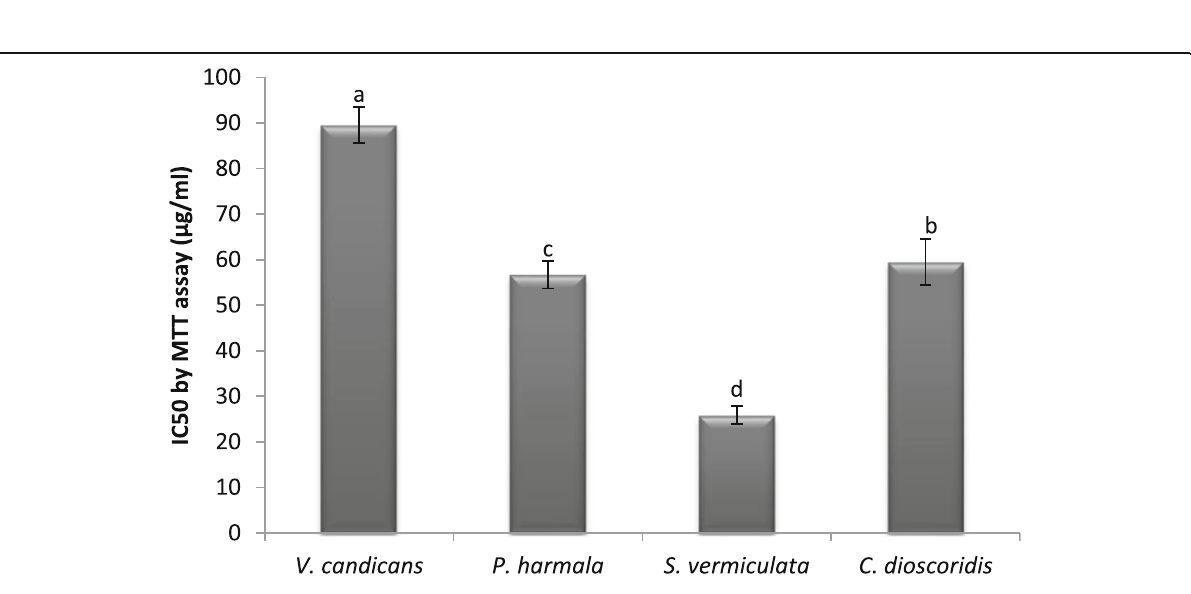
Fig. 2 Antitumor activity (IC 50 value) of the ethanolic extract of four Egyptian wild plant species against HepG2 cell line. Values having different superscripts are statistically significant at P <